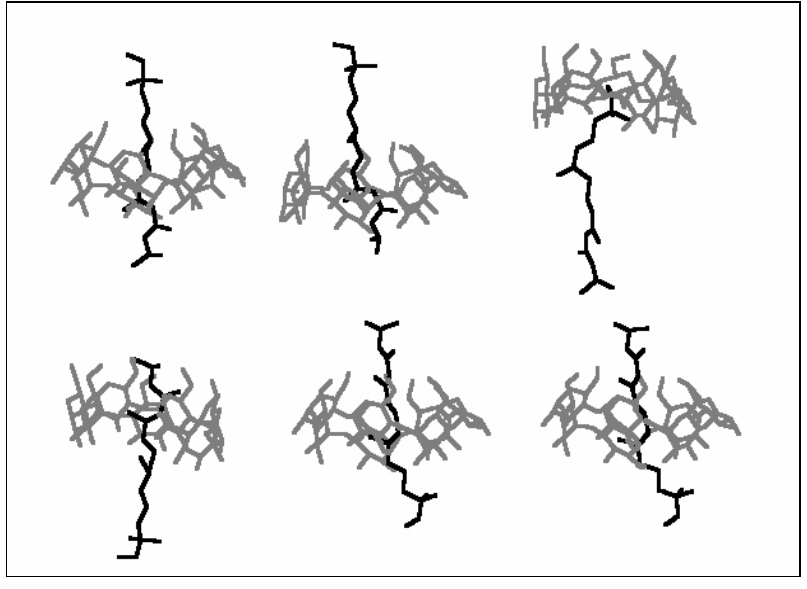
Figure 6. Sketch of the different topologies for the entry of the guest molecule into the cavity of the BCD